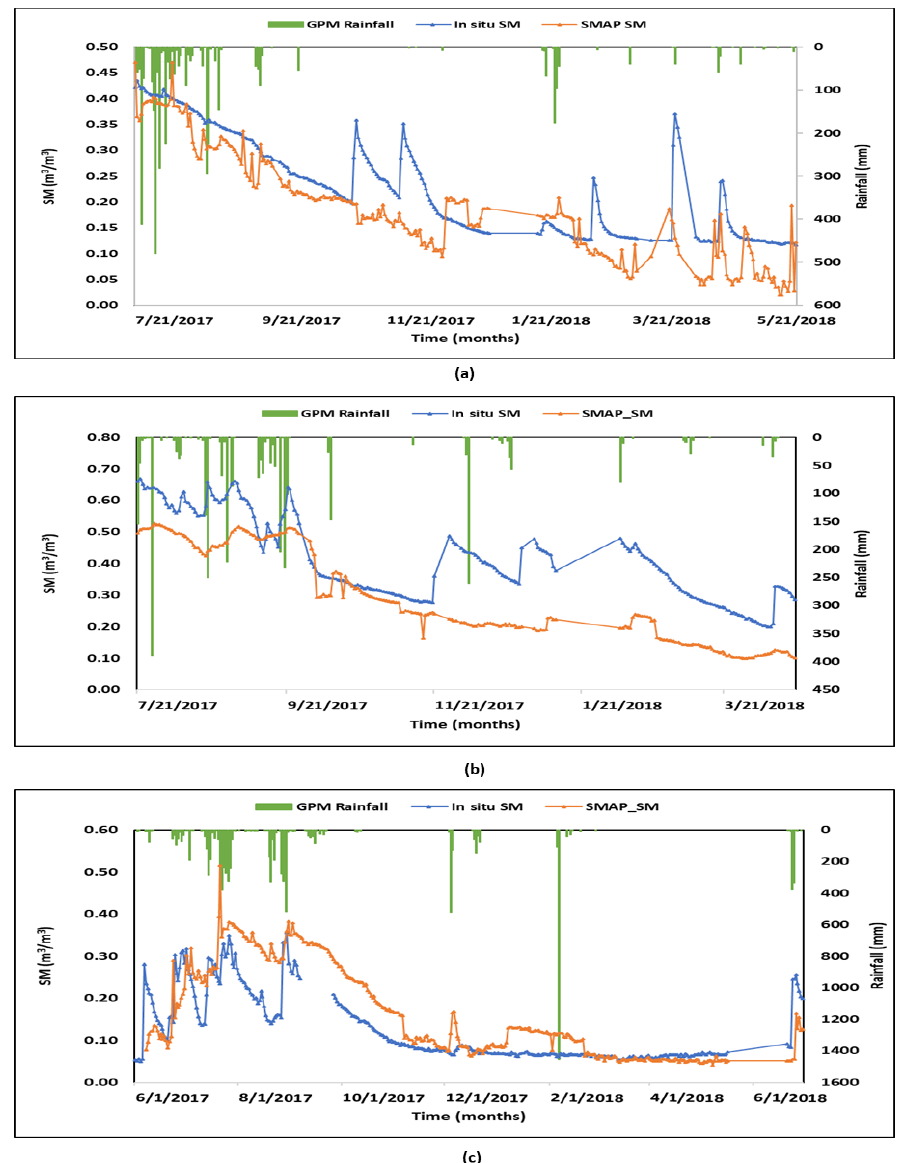
Figure 8. Temporal plot between the SMAP SM, in situ SM and GPM rainfall for ( a ) Varanasi, Uttar